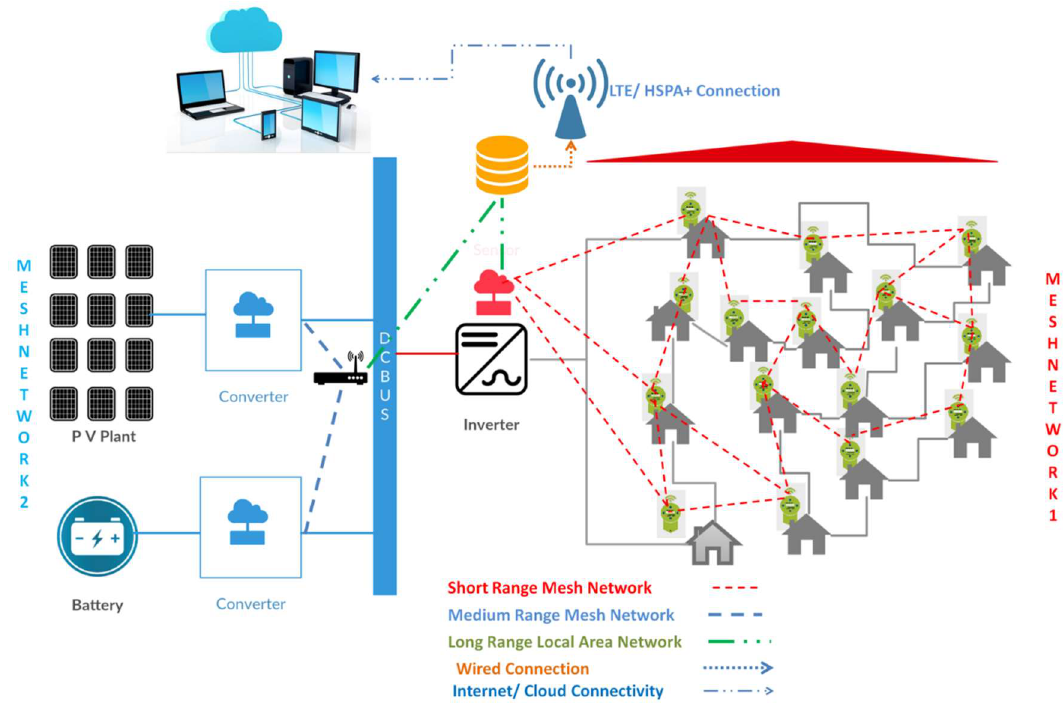
Figure 5. Communication architecture of the microgrid.